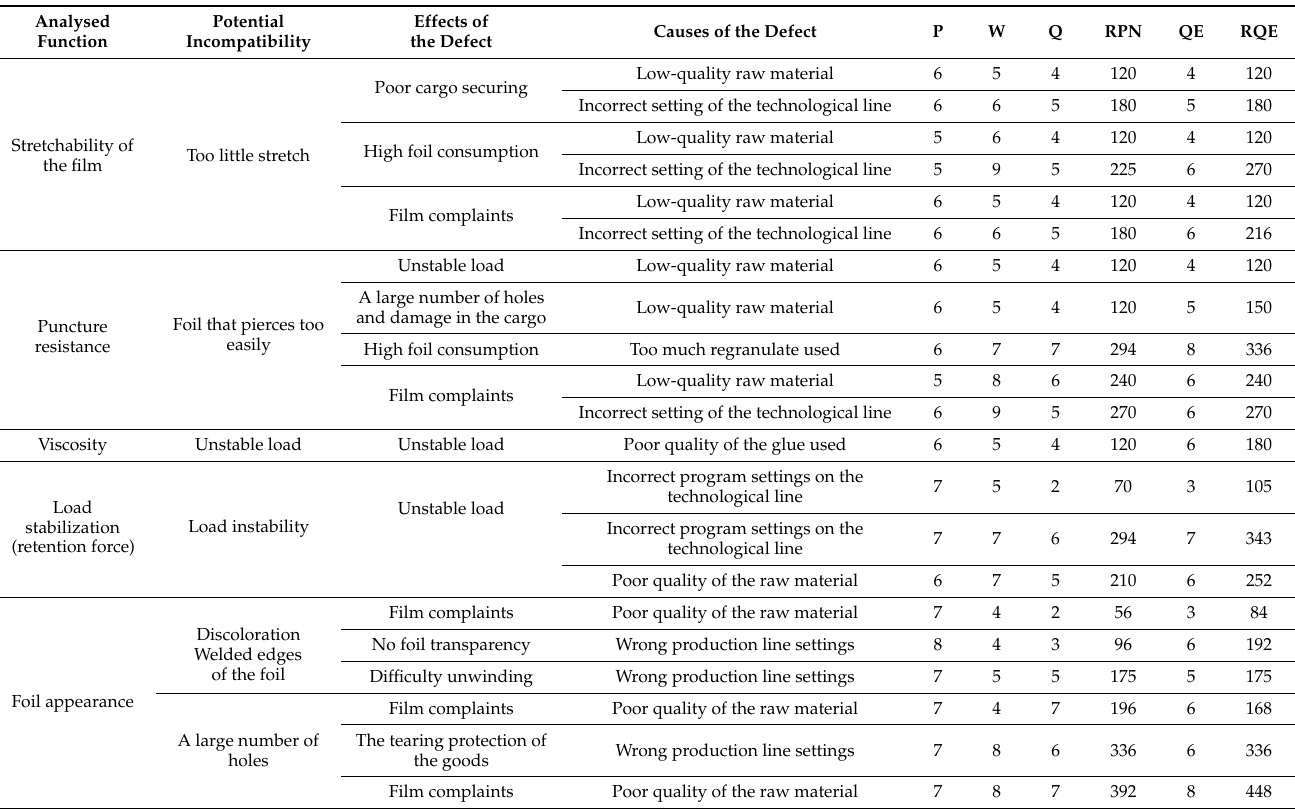
Table 13. Comparison of results from the traditional approach of the FMEA method with the proposed approach of the Fuzzy QE-FMEA